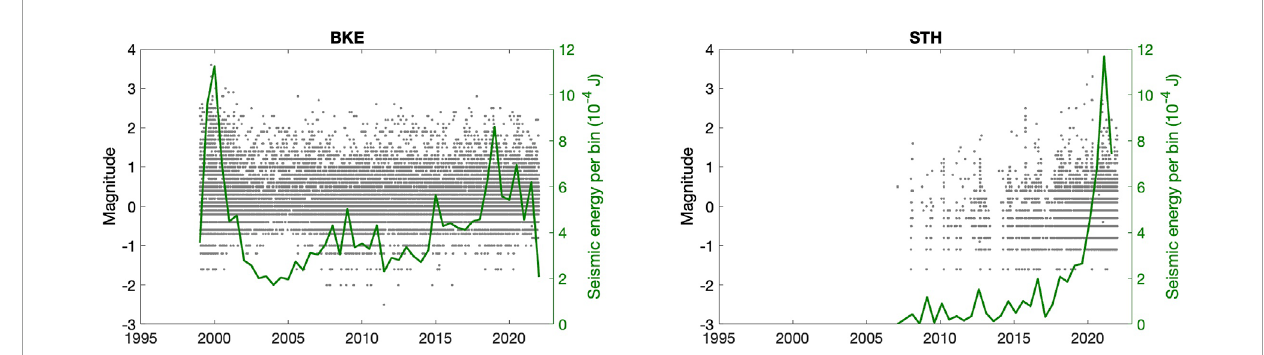
FIGURE 3 Seismic activity recorded at BKE and STH (grey dots) and time series of seismic energy release per bin of 6 months (green, solid line).